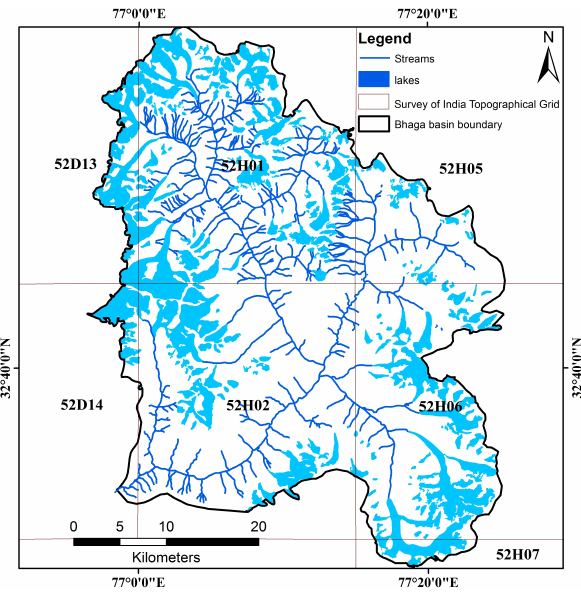
Figure 2: Total glaciated area of Bhaga